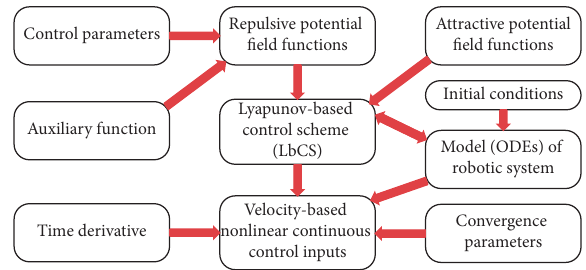
Figure 3: The block diagram outlining the LbCS